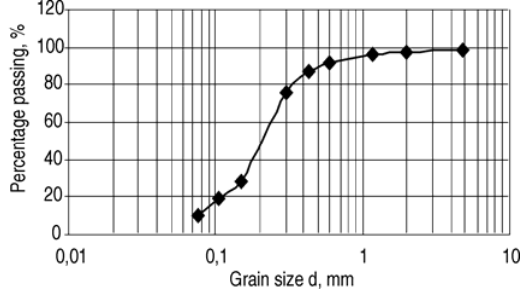
Fig 8 . Grading curve of fine